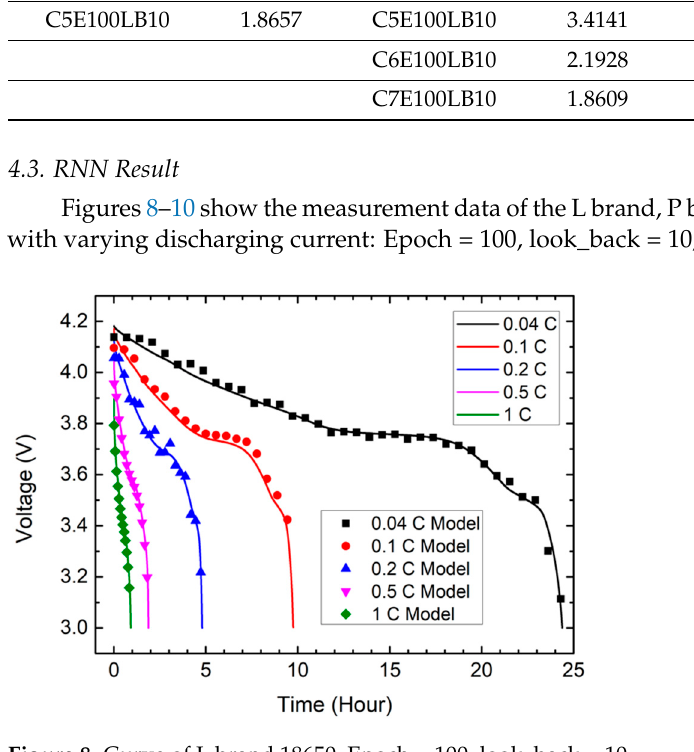
Figure 10. Curve of S brand 18650, Epoch = 100, look_back = 10.